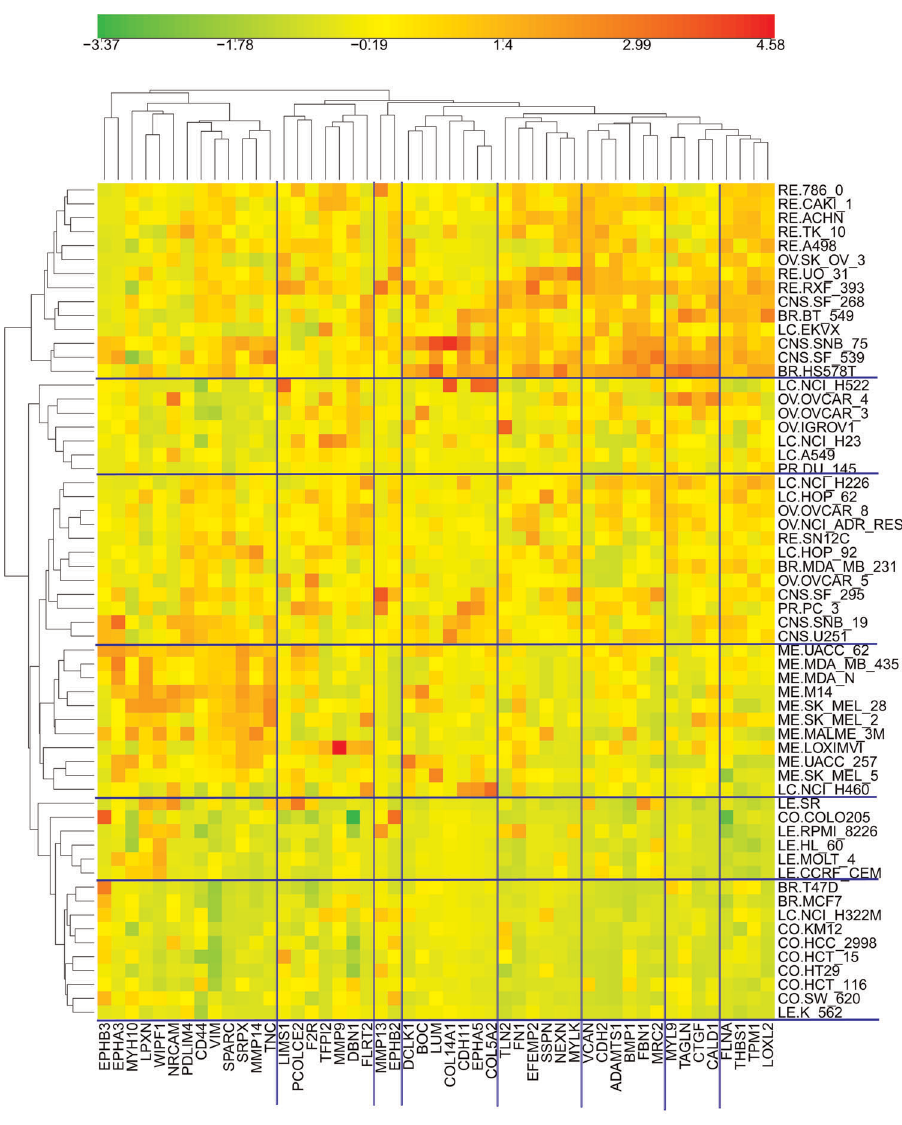
Figure 14. Relationship between cell migration-related genes in this report with EMT-upregulated genes reported by Thomson et al [ 87 ] : CIM of the expression of the EMT-upregulated genes in the NCI-60 cell line